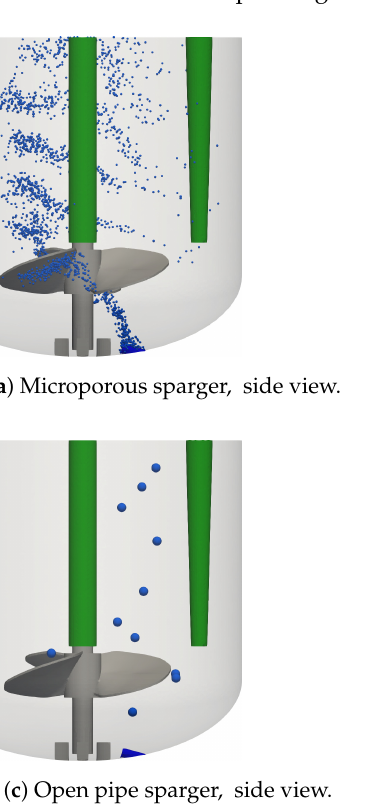
Figure 4. Bubble dispersion for the microporous sparger ( a , b ) base case, condition #4, and the open pipe sparger ( c , d ) condition #8. V = 1.7 L, n = 100 rpm, and Q = 50 mL min − 1